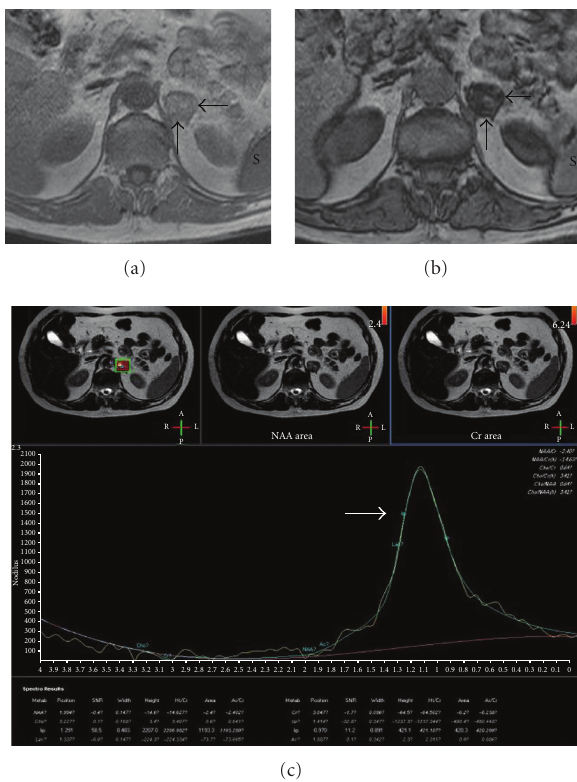
Figure 3: In axial magnetic resonance (MR) imaging, in-phase (a) and out-of-phase (b) images demonstrate a prominent signal loss in the adrenal mass (black arrows) as we take the intensity of the spleen (S) as an internal standard. MR spectroscopy (c) revealed the presence of high lipid content in the left adrenal mass(white arrow). All these findings were consistent with adrenal